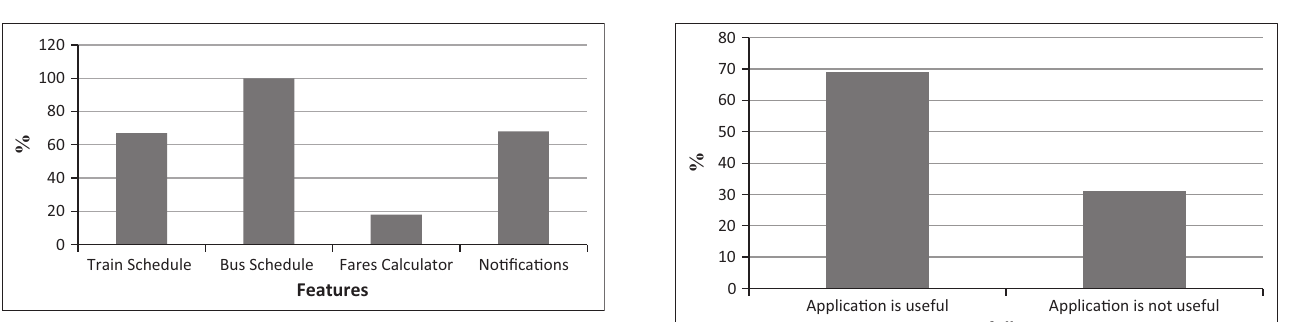
FIGURE 6: Features used.